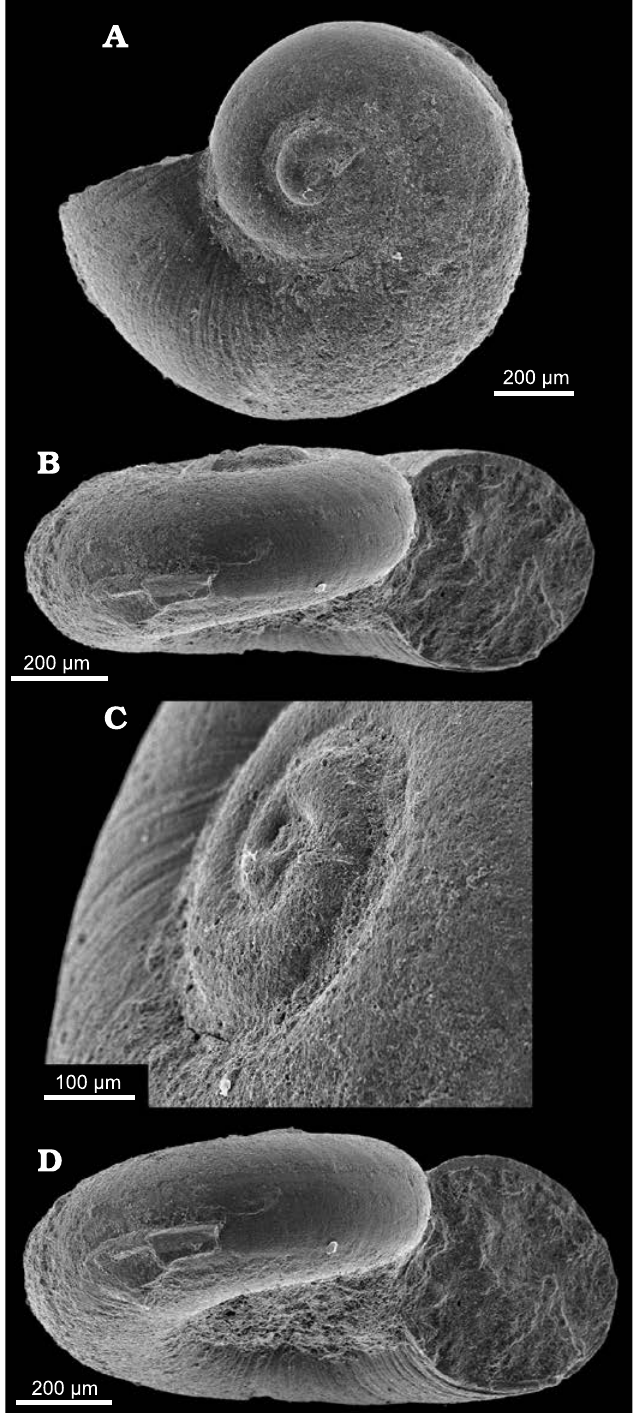
Fig. 23. Hyalogyrinid gastropod Alexogyra marshalli Bandel, 1996 from Lago Antorno, northern Italy, Cassian Formation, Carnian, Upper Triassic. A . PZO 12842, in apical view. B . PZO 12843, in apertural view. C . PZO 12844, protoconch in oblique lateral view. D . PZO 12845, in oblique aper- tural view to show